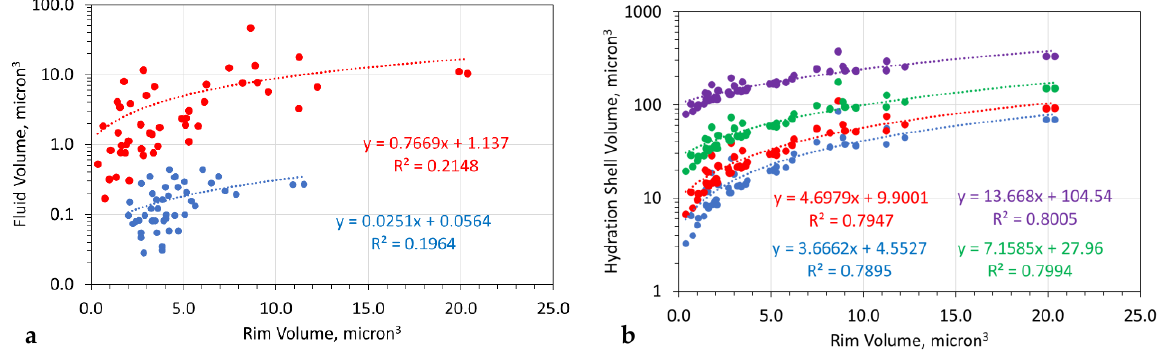
Figure 12. Evolution of an initial flocculate particle between 2 h after placement in water and 4000 h after placement in water. Data set: Figure 11; ( a ) rim volume versus fluid volume in the particle core; blue = after 2 h; red = after 4000 h; ( b ) hydration shell volume versus rim volume after 4000 h; blue = hydration shell thickness of 0.25 microns; red = hydration shell thickness of 0.5 microns; green = hydration shell thickness of 1 micron; purple = hydration shell thickness of 2 microns.